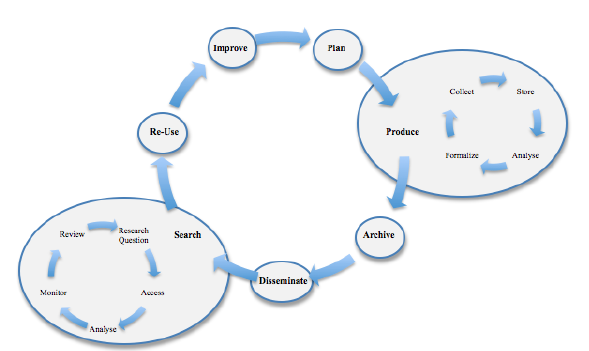
Figure 1. Data Management Cycle using and Agile